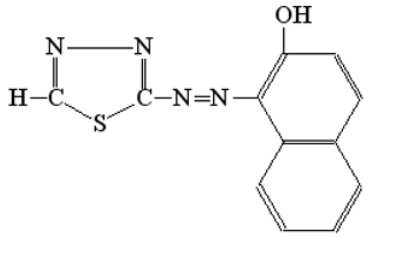
Figure 1. Chemical structure of the